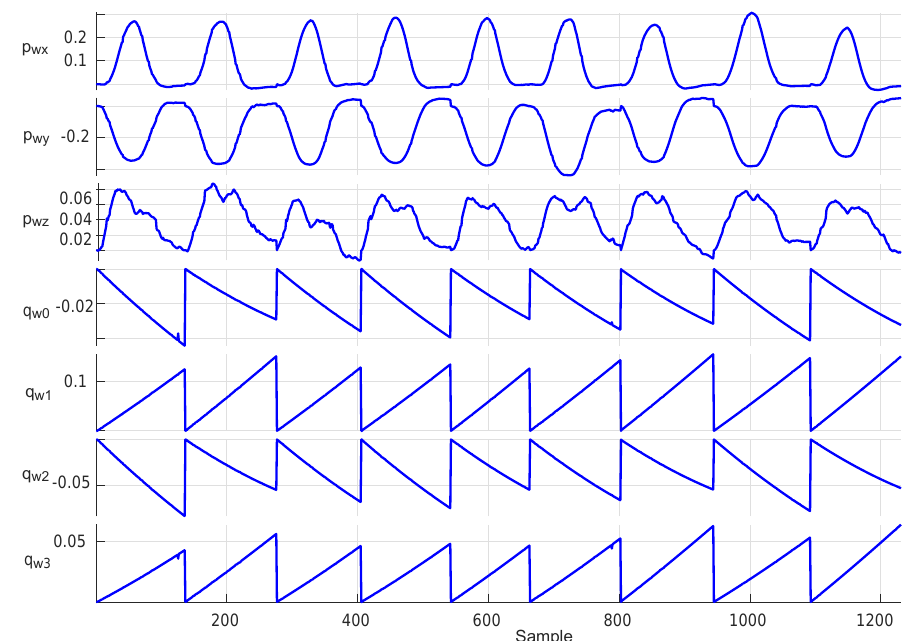
Figure 12. Time evolutions of operator’s wrist position and orientation trajectories for a sequence of nine bottle pick-and-place operations.